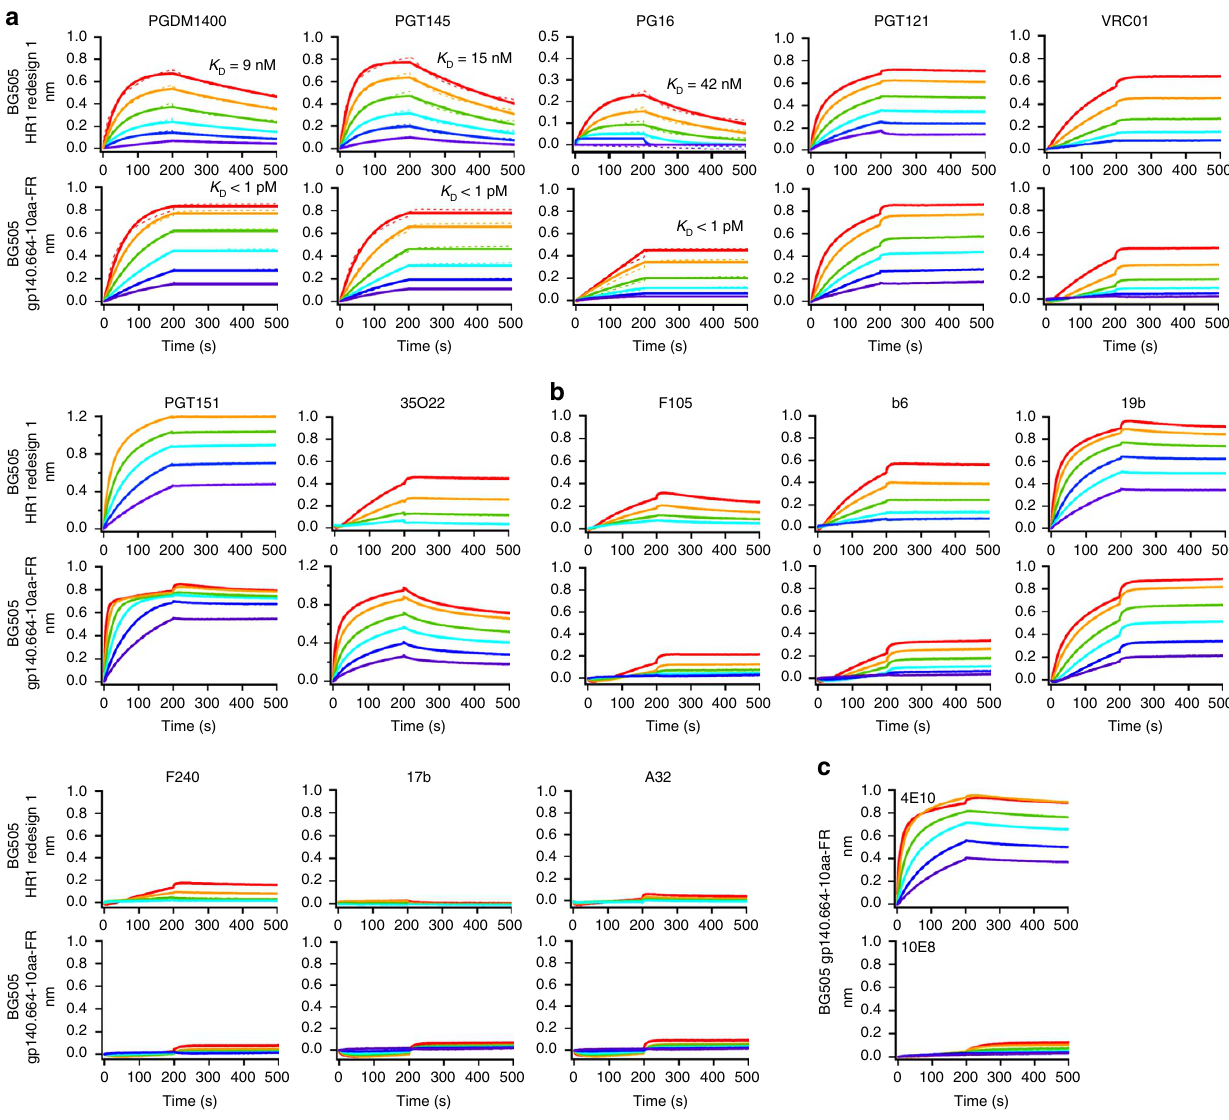
Figure 5 | Antigenic evaluation of gp140-FR nanoparticles. Octet binding of HR1-redesigned gp140 trimer and gp140.664-10aa-FR nanoparticle to a panel of ( a ) bNAbs and ( b ) non-NAbs. ( c ) Octet binding of gp140.681-10aa-FR to MPER-directed bNAbs 4E10 and 10E8. For gp140.664-FR and gp140.681-10aa- FR, detailed antibody binding profiles are shown in Supplementary Fig. 5. Sensorgrams were obtained from an Octet RED96 using a titration series of six starting at the maximum of 200nM for HR1-redesigned gp140 trimer and 35nM for gp140.664-10aa-FR nanoparticle. K D values are calculated from 1:1 global fitting for apex-directed bNAbs PGDM1400, PGT145 and PG16 in ( a